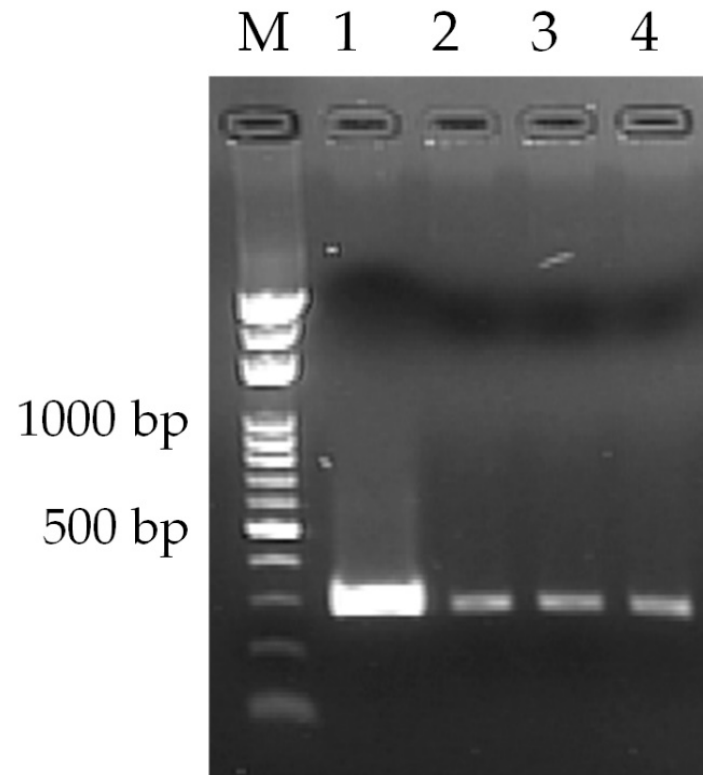
Figure 10. Agarose gel electrophoresis of the RT-PCR yield. Lane (M): DNA ladder; lane (1): positive control from the conventional PCR machine; lanes (2~4): RT-PCR products from the oscillating thermocycler using various volumes of mineral oil for 30 µL, 20 µL, and 10 µL, respectively.